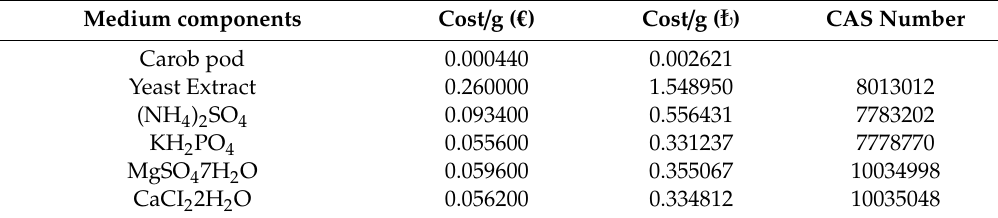
Table 4. Cost of nutrients used in di ff erent media compositions.